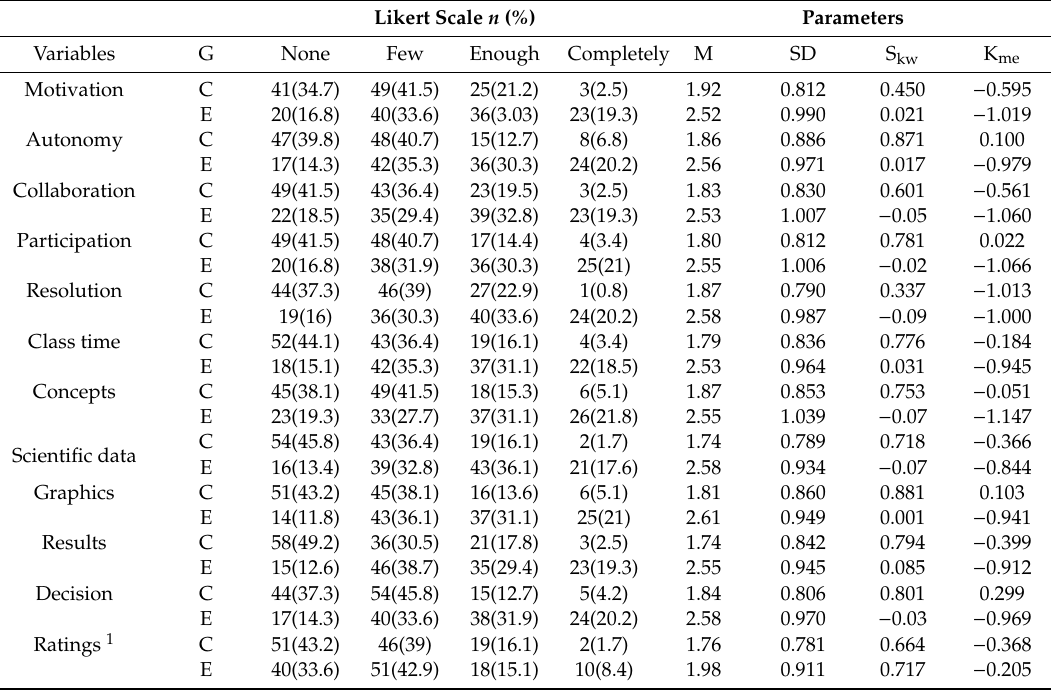
Table 4. Results obtained for the study variables in the control and experimental